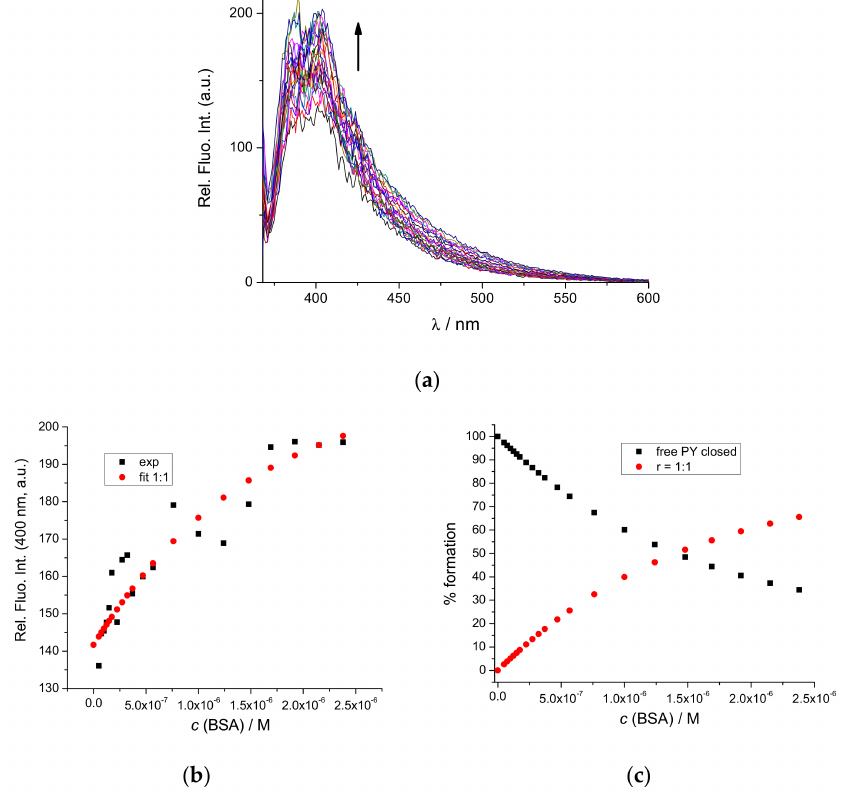
Figure 12. ( a ) Fluorimetric titration of DAE-NH-Py closed ( c = 1 × 10 − 6 M; λ exc = 342 nm) with BSA; ( b ) Dependence of emission at λ max = 400 nm on c (BSA): experimental ( (cid:4) ) and HypSpec2014 [43] calculated data ( • ); ( c ) Distribution of spectroscopically active species dependent on a c (BSA) based on HypSpec2014 processing [43], free DAE-NH-Py closed ( (cid:4) ); 1:1 complex ( • ). Done at pH 7.0, buffer sodium cacodylate, I = 0.05